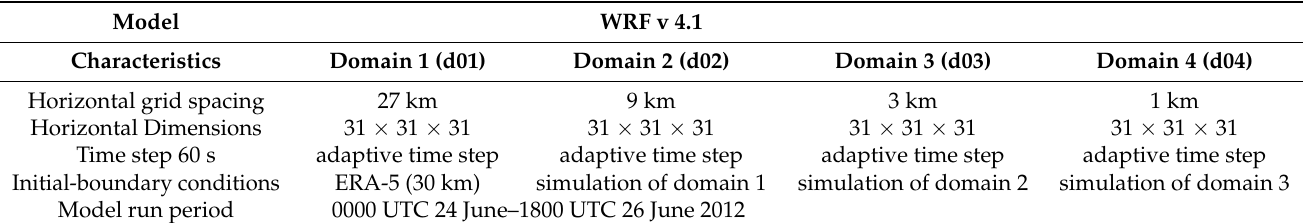
Table 1. Weather Research and Forecasting model settings used in the current